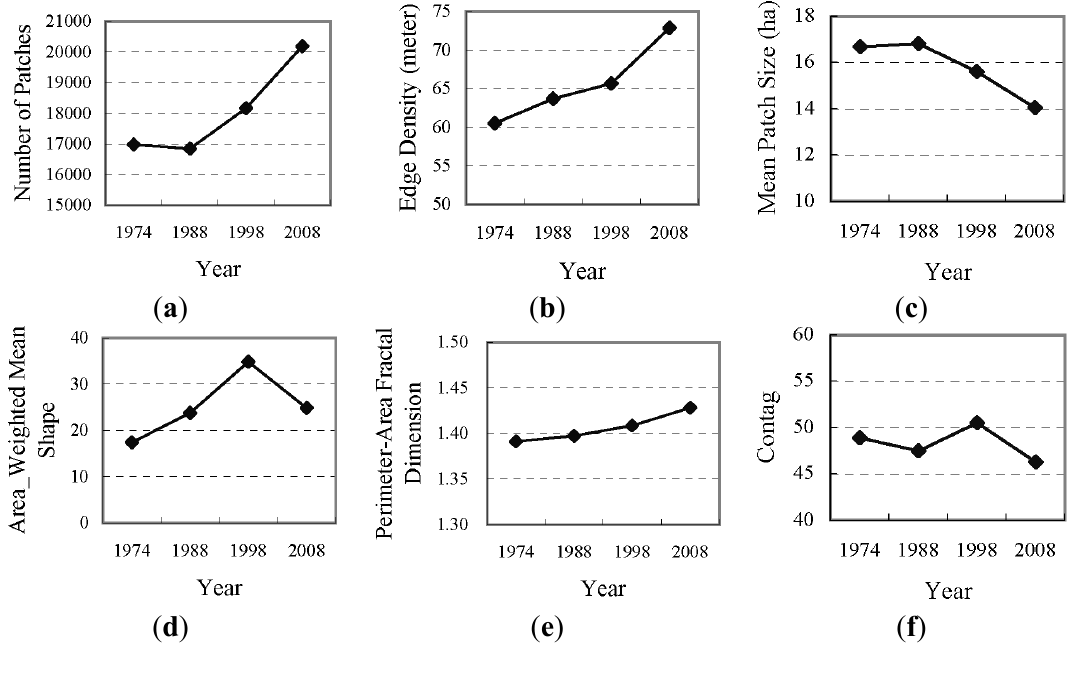
Figure 4. Metrics of land-use/land-cover at the landscape